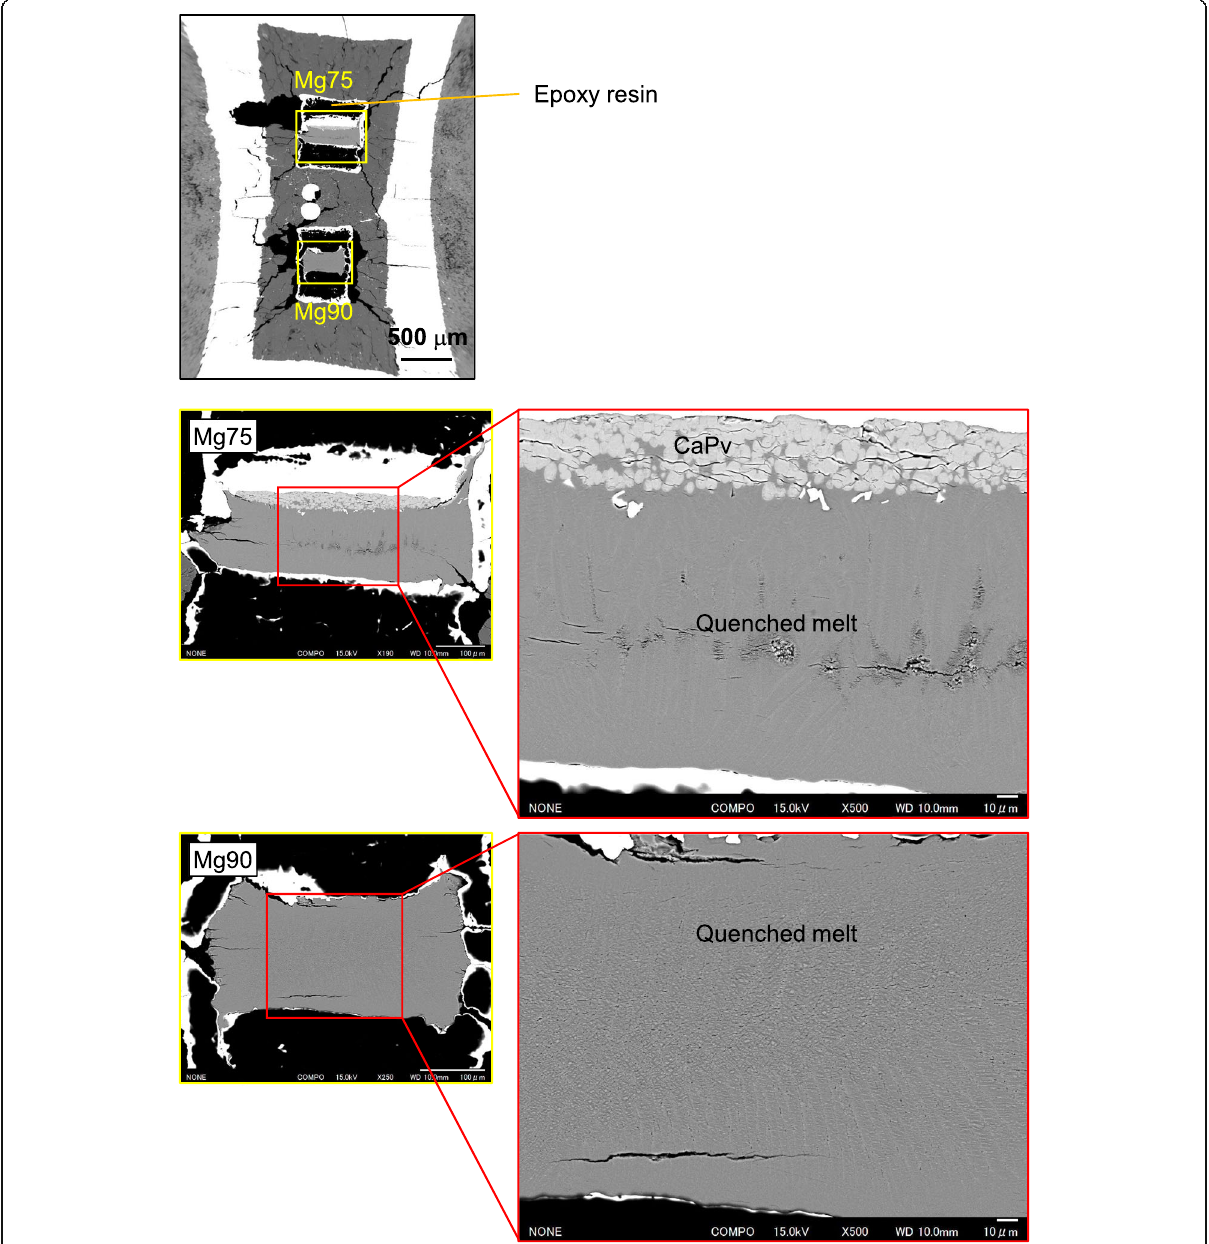
Fig. 5 Backscattered electron images for the samples recovered from high pressure and high temperature (Run No. OS3095). Quenched melts were found at most of the sample areas. In Mg75, the liquidus phase, CaSiO 3 -rich perovskite (CaPv), was found at the coldest